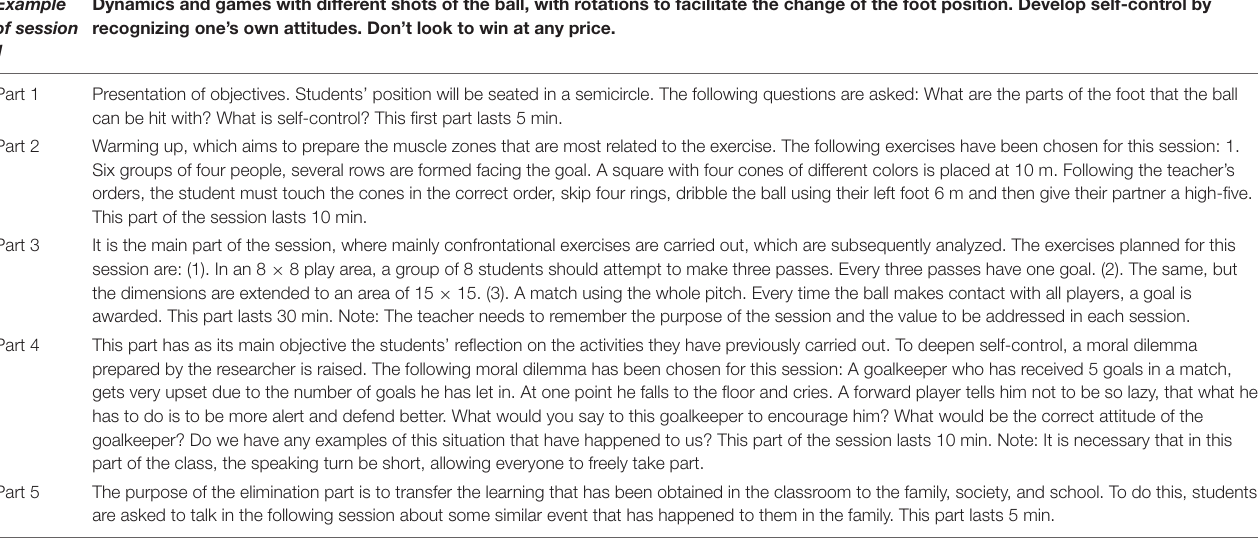
TABLE 1 | Description of the Delphi session. Example of